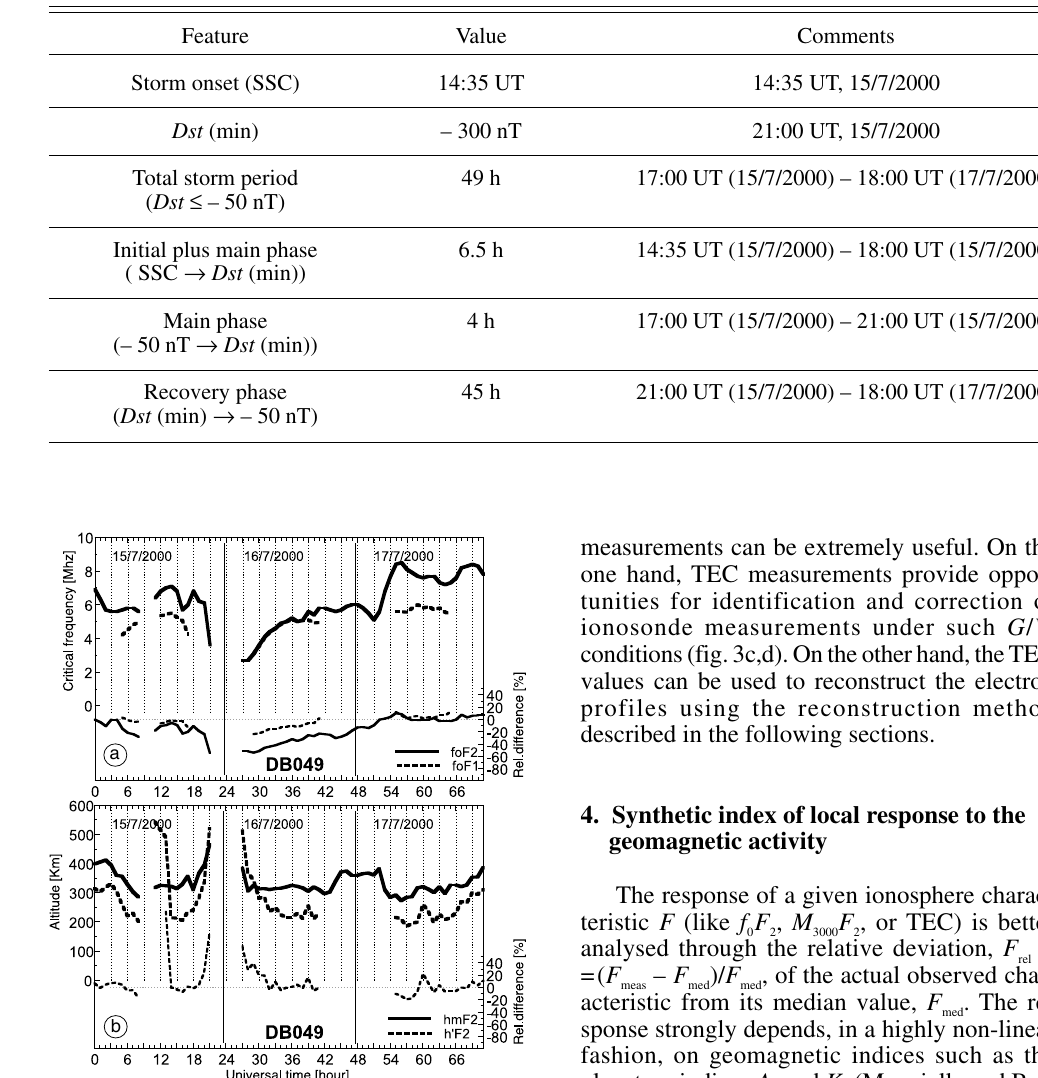
Fig. 4a,b. Ionosonde measurements during the 15th - 17th July 2000 geomagnetic storm recorded at the Dourbes ionosonde station DB049 (4.6 ° E, 50.1 ° N).